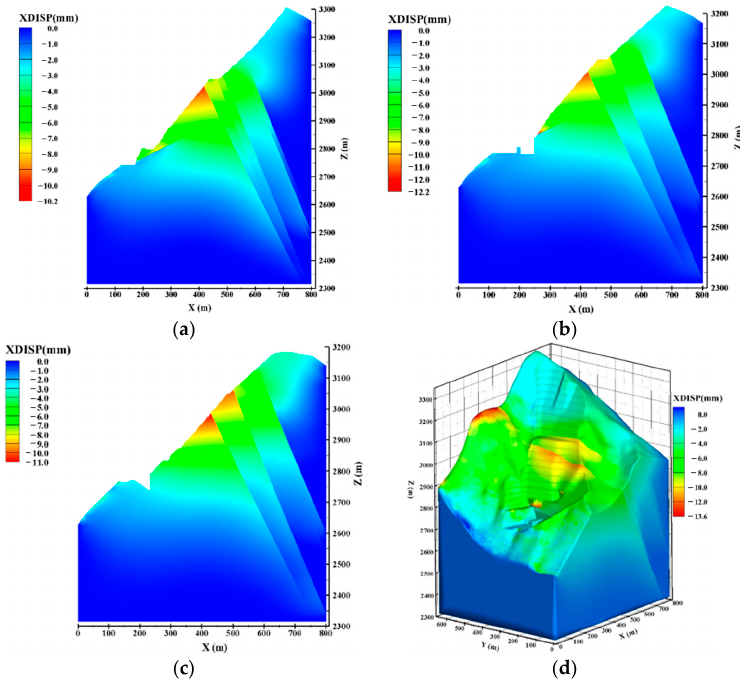
Figure 8. Transverse riverward displacement distribution under condition II. ( a ) profile 5; ( b ) profile 10; ( c ) profile 13; ( d ) entire body.